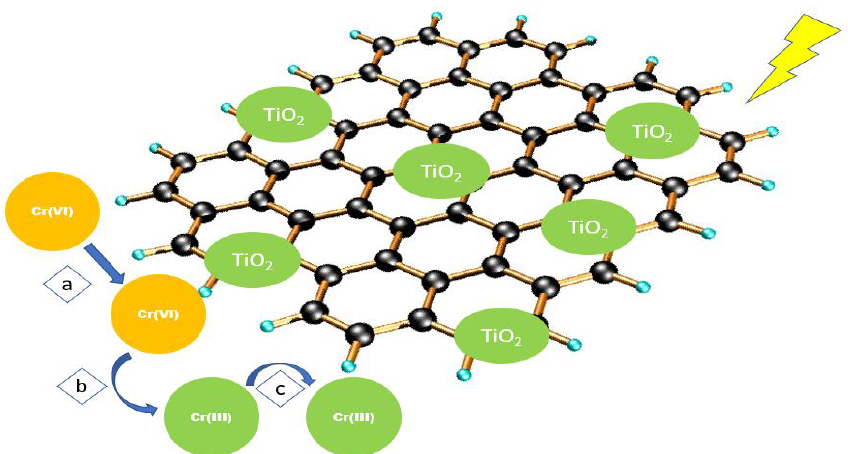
Figure 9. Removal mechanism of Cr(VI) using GO/TiO 2 nanocomposite.